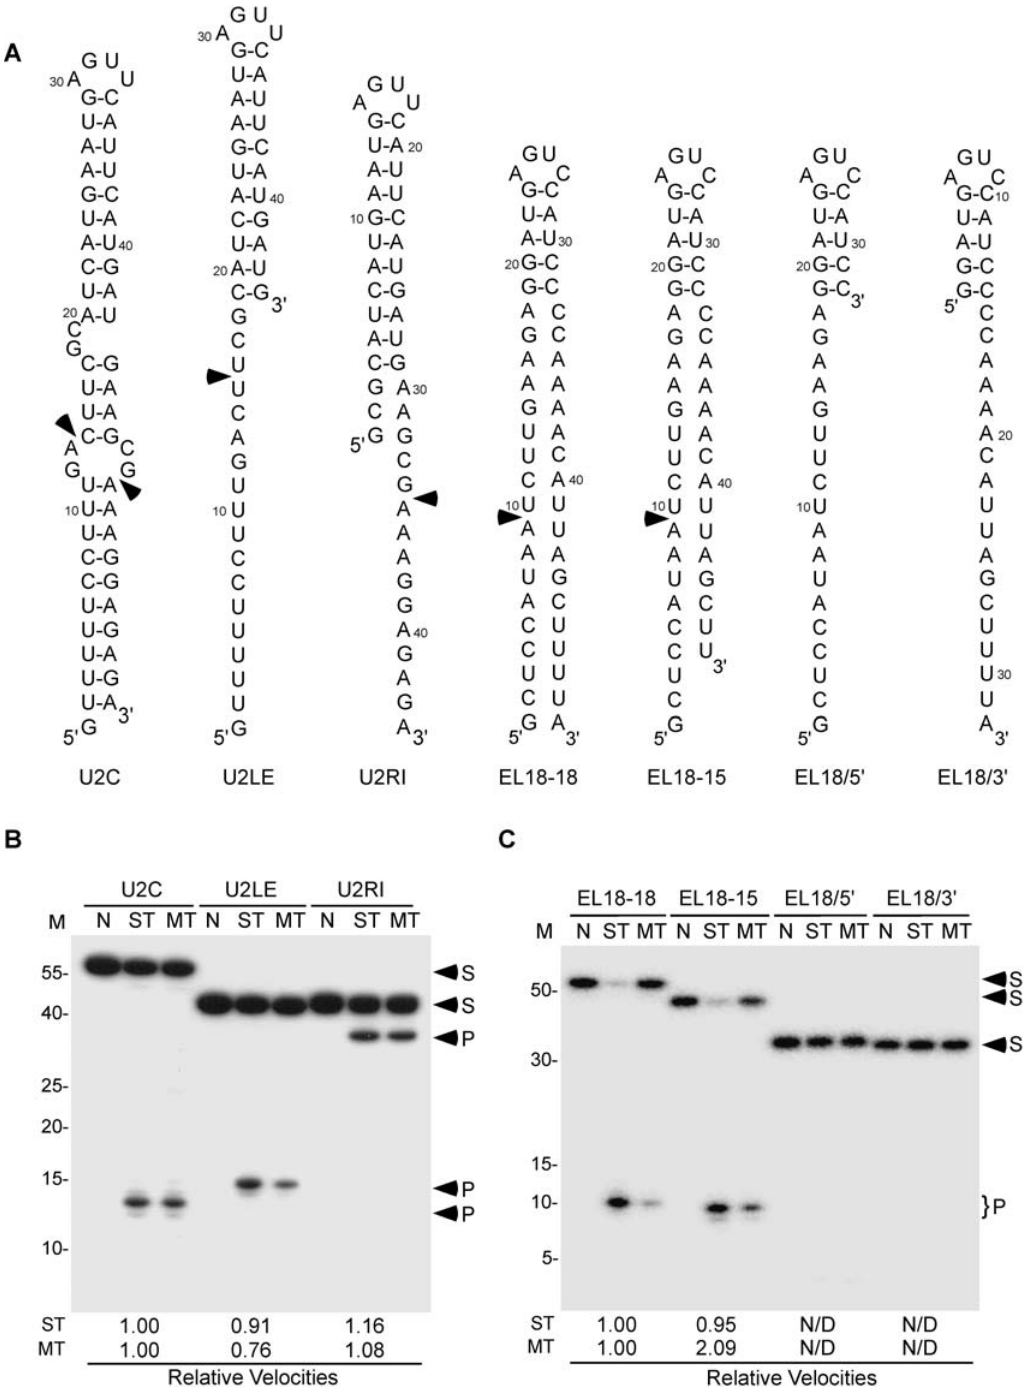
Figure 1. Rnt1p does not require a complete A-form helix for cleavage. (A) Schematic representations of Rnt1p substrates used in B and C. U2C, U2LE, and U2RI were derived from Rnt1p cleavage site at the 3 9 -end of U2 snRNA[9]. EL18-18, EL18-15, EL18/5 9 , and EL18/3 9 are derived from the cleavage site at the 3 9 end of U5 snRNA[18]. The arrowheads indicate major Rnt1p cleavage sites. (B) and (C) The different 5 9 -end labeled substrates were incubated in the absence (N) or presence of recombinant Rnt1p. Cleavage was carried out either in enzyme excess to measure the single turnover rate (ST) or in RNA excess to measure the multiple turnover rate (MT). The cleavage products were fractionated by 20% denaturing PAGE and visualized by autoradiogram. The cleavage efficiencies are presented as fractional velocities relative to the parental substrate. The values reflect the average of three independent experiments. The RNA marker (M) is indicated on the left. The positions of the cleavage products (P) and the substrates (S) are indicated by arrowheads on the right.